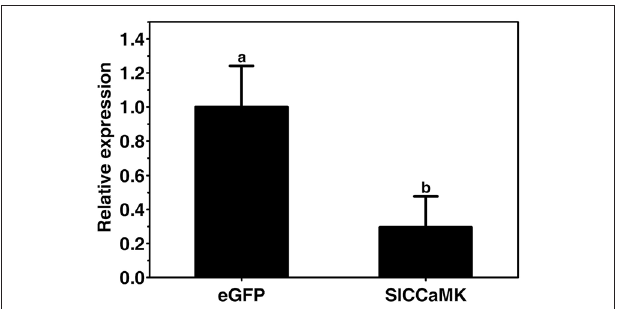
FIGURE 7 | Evaluation of gene silencing efficiency. Expression levels of the SlCCaMK gene in tomato plants were examined by RT-qPCR. Significant difference between expression values of the SlCCaMK gene in silencing-treated plants and those of the eGFP control plants is indicated as a lowercase letter ( P ≤ 0.05 , by Student’s t -test).